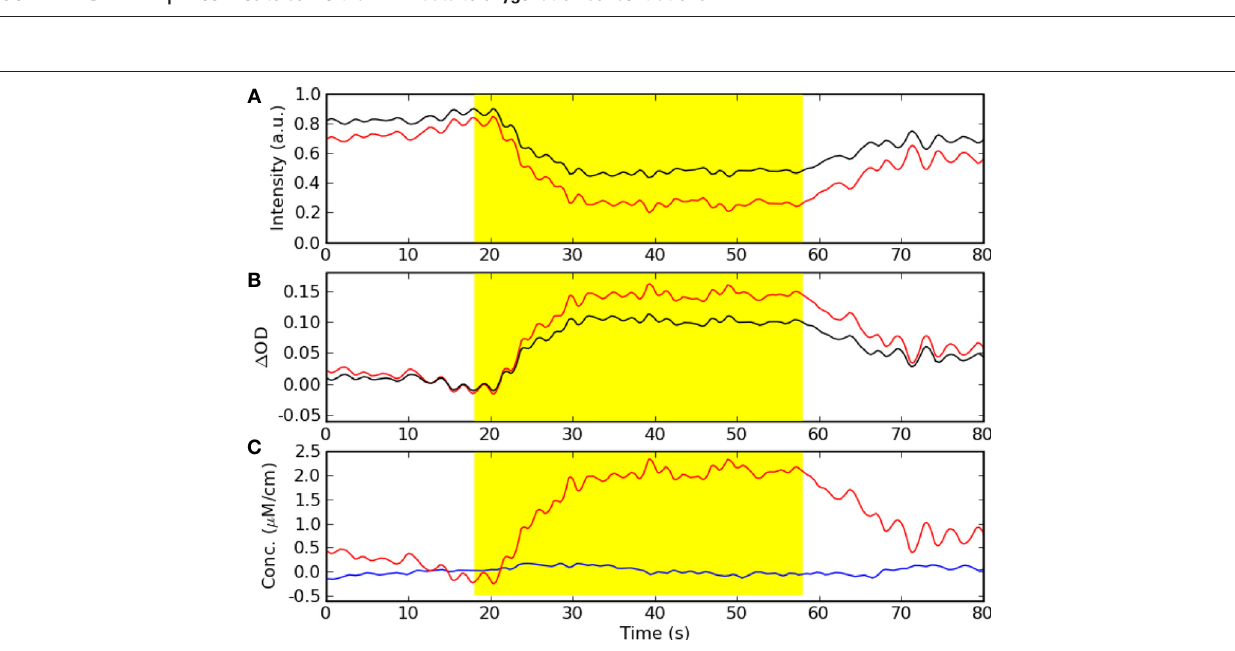
FIGURE 5 | Spectroscopic conversion steps of NIN data time series from one source–detector pair. (A) Raw recorded NIN light intensity data from two wavelengths, in arbitrary units. (B) Data from (A) after log transformation to optical density units. (C) Data from (B) after conversion to hemoglobin concentration units (red = oxy-Hb, blue = deoxy-Hb, yellow = period of task